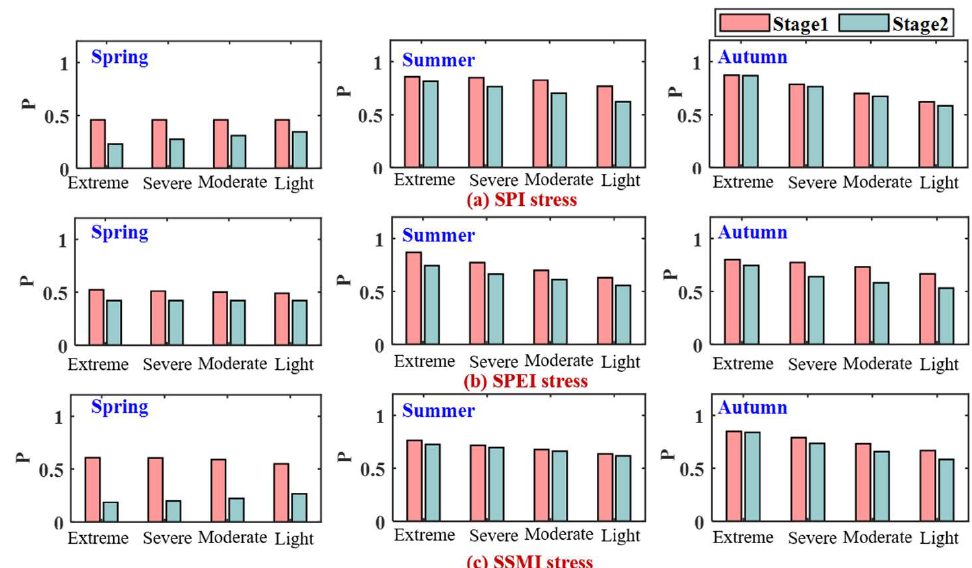
Figure 10. The lower reaches of TRB.